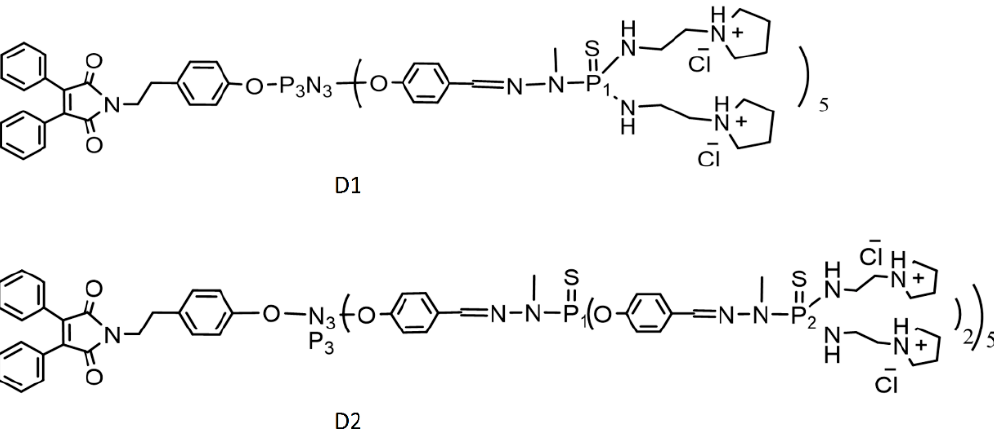
Figure A1. Chemical structure of the studied amphiphilic dendrons of the first (D1) and second (D2) generation. Details on the preparation of D1 and D2 have been published as supplementary data to the article [17], where dendron D1 is denoted as D1G1 · HCl and dendron D2 as D1G2 · HCl. This supporting information is available free of charge at https://pubs.acs.org/doi/10.1021/acs.bioconjchem.0c00716 (accessed on 4 November 2021). Table A1. Descriptive statistics and differences in the selected hematology and coagulation parameters across experi- mental conditions.